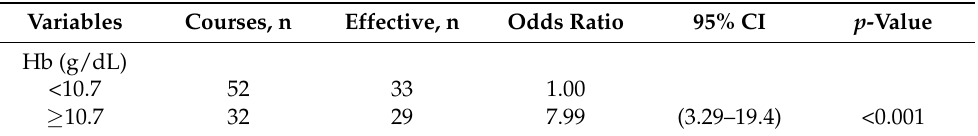
Figure 5. ROC curves of ( a ) Hb, ( b ) RBC, and ( c ) MCH with Hb > 12 g/dL within 12 weeks. Table 3. Univariable logistic regression models for the relationship between Hb levels at baseline and Hb > 12 g/dL within 12 weeks.